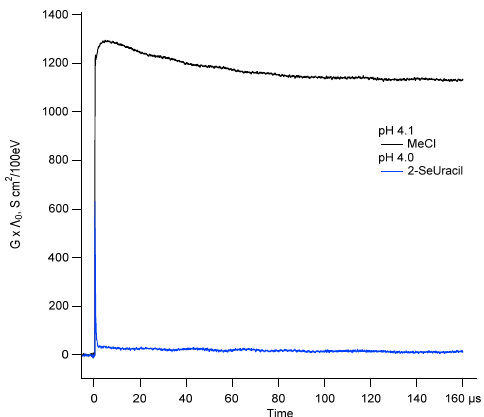
Figure 5. Comparison of equivalent transient conductivity changes represented as G × Λ 0 vs. time after the pulse of electrons in N 2 O-saturated solutions containing 1 mM of 2-SeU at 4.0 (blue line) to CH 3 Cl-saturated aqueous solutions at the pH 4.1 (black line).